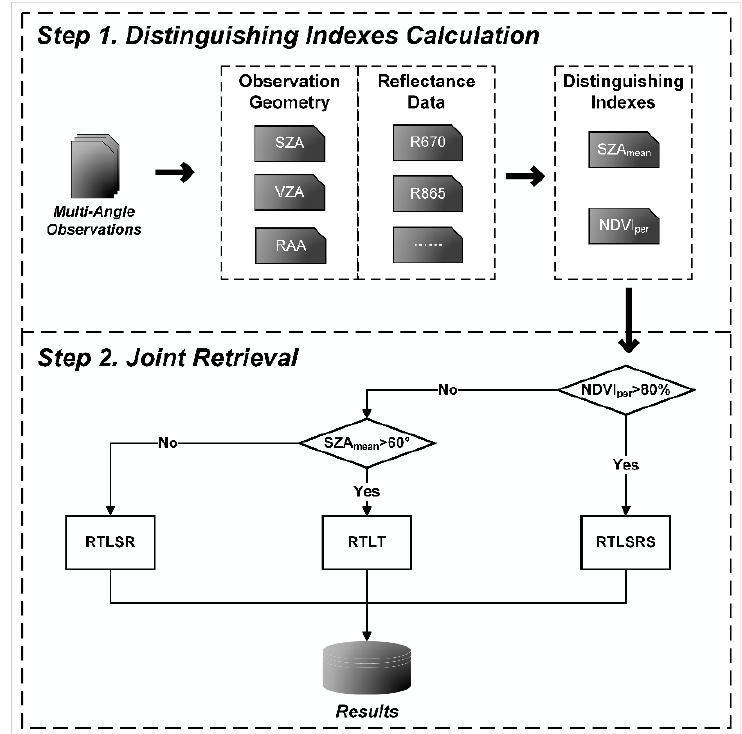
Figure 2. Workflow of the Simple Joint Retrieval Strategy (SJRS). SZA mean is the mean Solar Zenith Angle (SZA) of the observations at the site. NDVI per is the percentage of the observations with Normalized Difference Vegetation Index (NDVI) < 0 at the site. RAA is Relative Azimuth Angle. R670 and R865 mean the reflectance in red (670 nm) and NIR (865 nm) bands. RTLSR, RTLT, and RTLSRS are the models mentioned in Section 2.2.